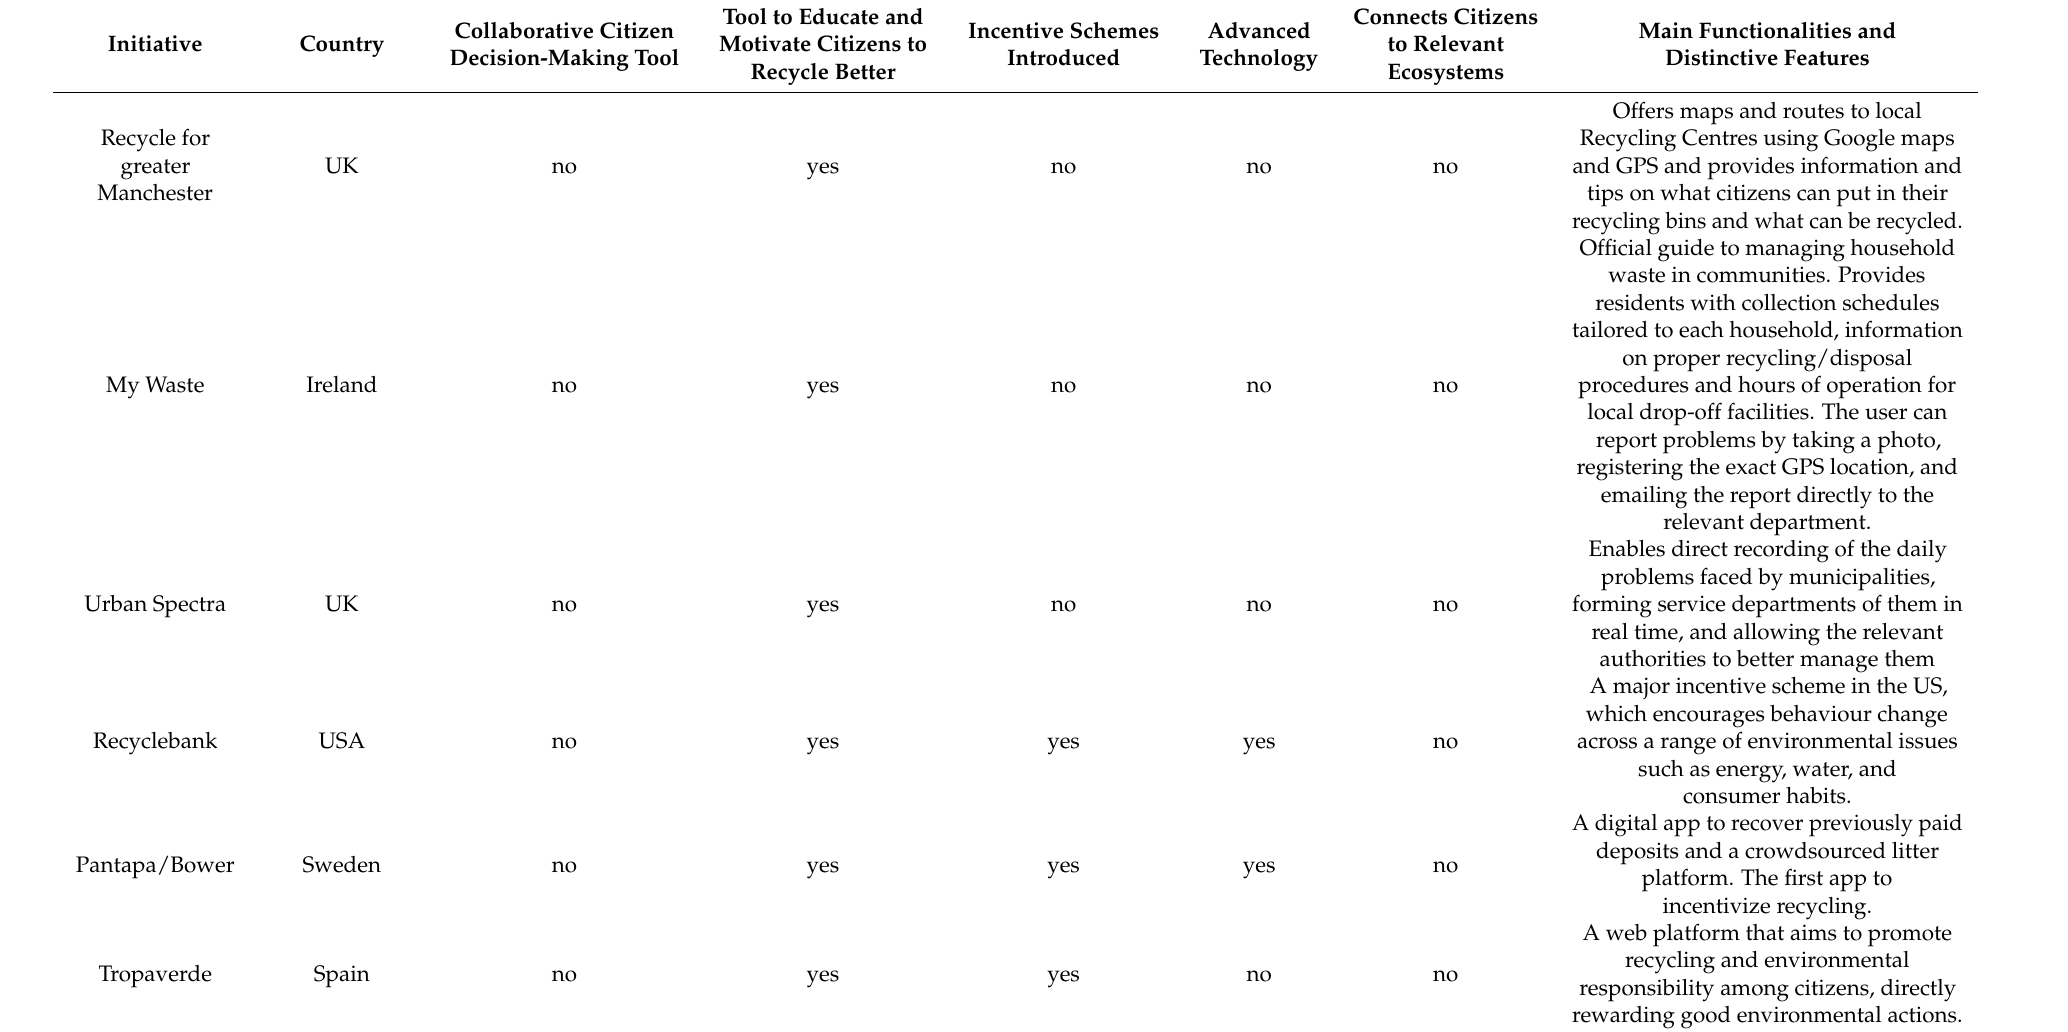
Table 1. A comparison of existing solutions that educate and motivate citizens to